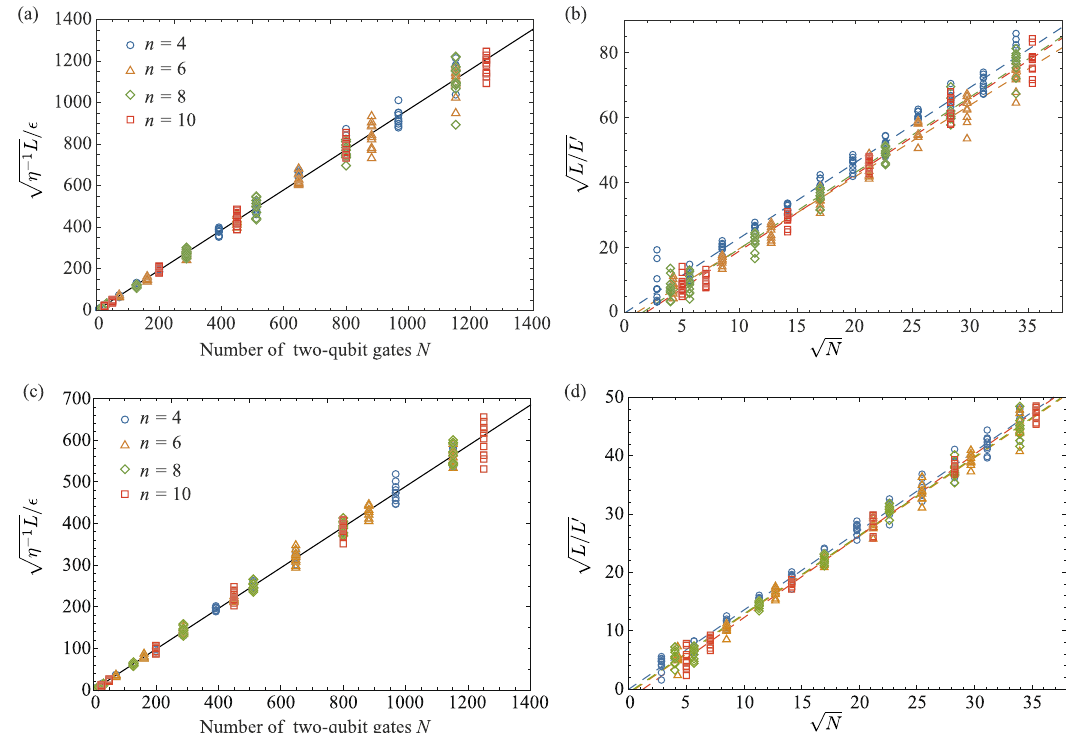
ffiffiffi p L before error mitigation. b , d Root mean square